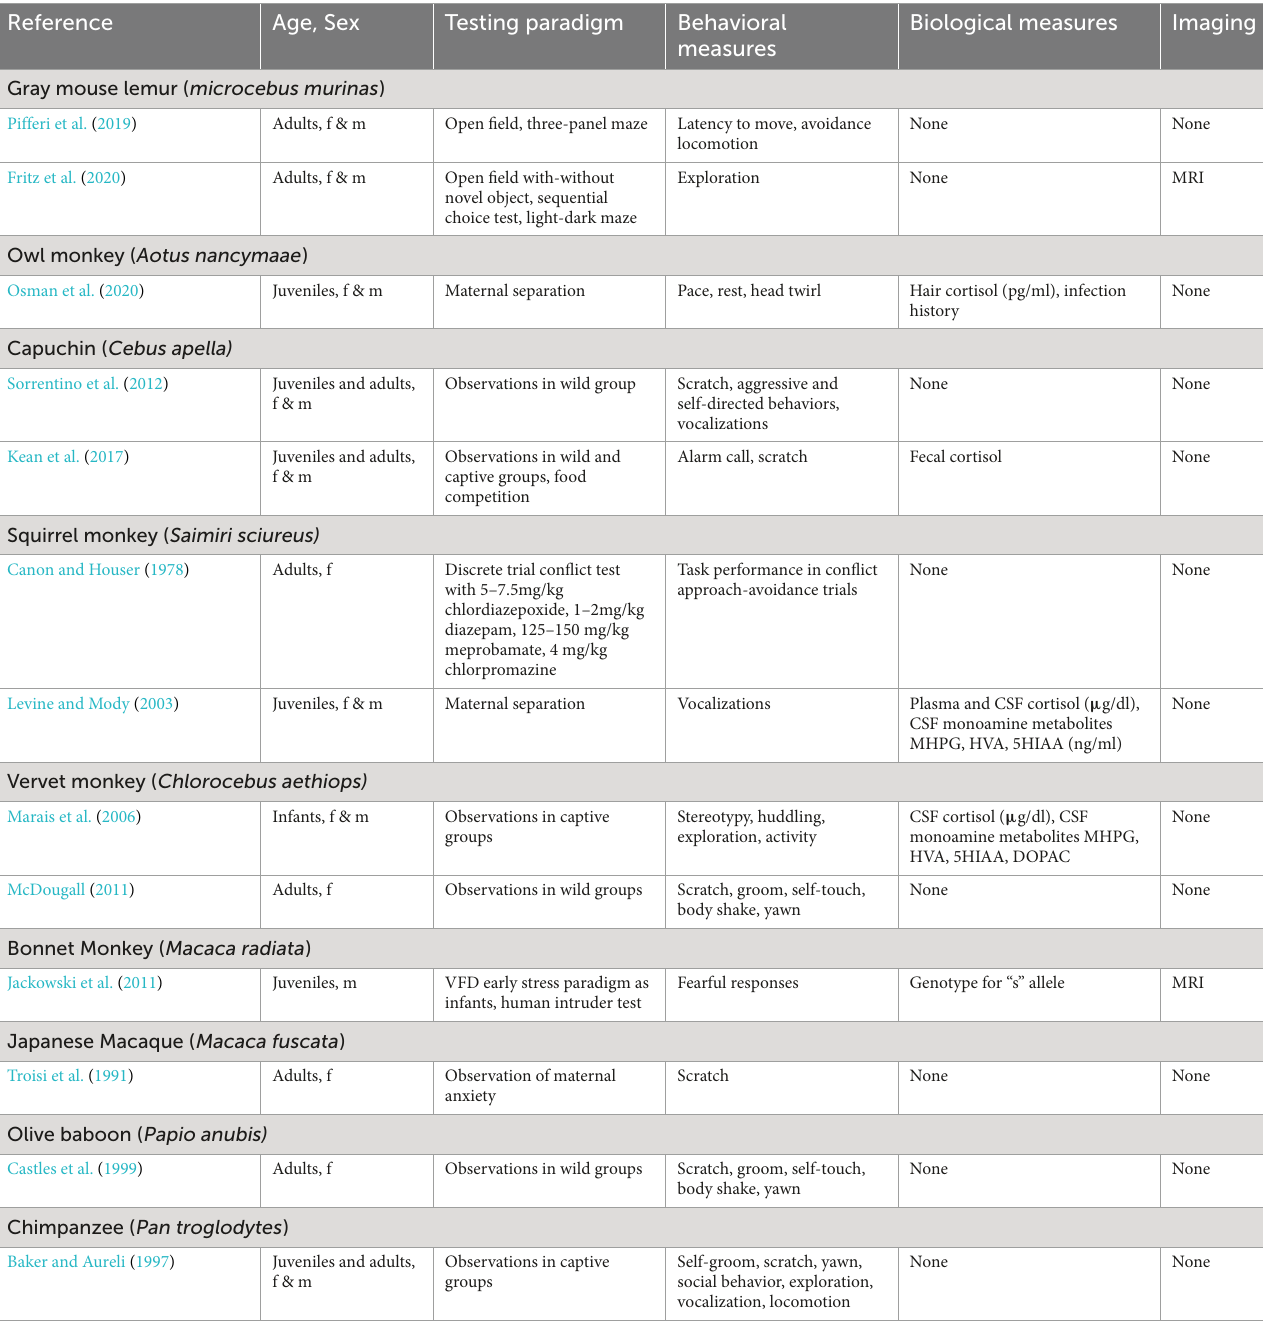
TABLE 5 Selected peer-reviewed publications describing methods of evaluation of depression- and anxiety-like behaviors in lemur (infant = 0–0.2 y; juvenile = 0.2–1 y; adult = 1–12 y); owl monkey (infant = 0–0.5 y; juvenile = 0.5–2 y; adult = 2–12 y); capuchin (infant = 0–1 y; juvenile = 1–6y; adult = 6–25